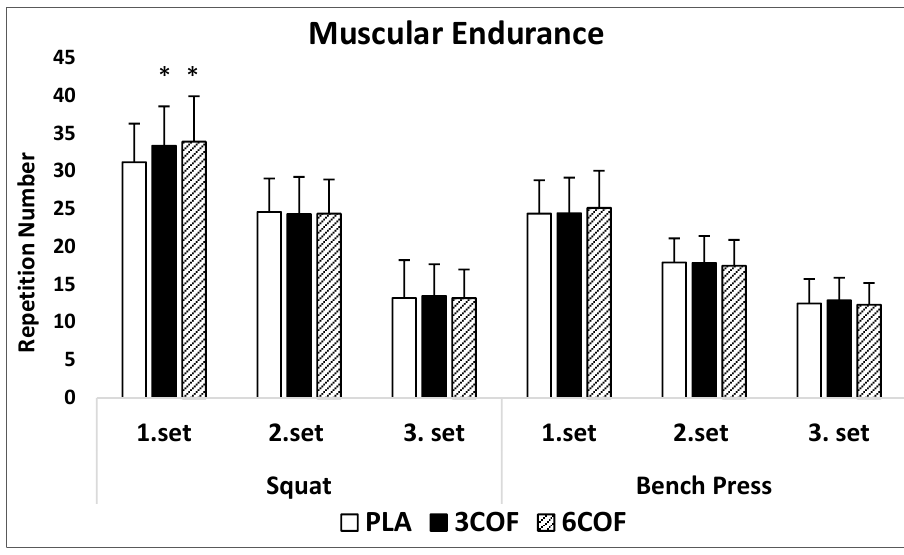
Figure 2. Mean (SD) repetition numbers for squat and bench press exercises over the three sets. * Significantly different from PLA.